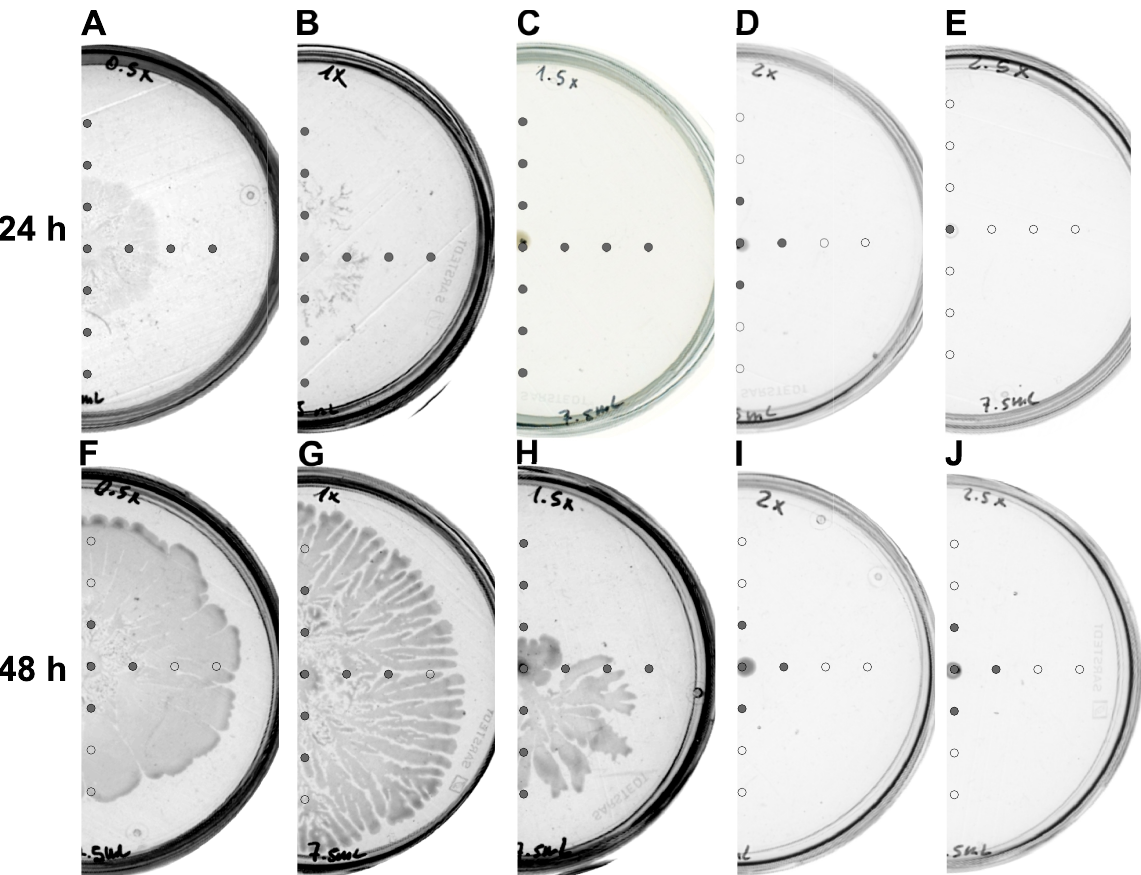
Fig 2. Swarming and AHLs production by Dickeya solani IFB102 on plates containing 0.5% of agar and the changing concentrations of B- medium: (A, F) 0.5x, (B, G) 1x, (C, H) 1.5x, (D, I) 2x, (E, J) 2.5x. Swarming assays were performed for 24 and 48 h, as indicated. Grey circles represent spots at which AHLs were detected. Open circles represent spots at which no AHLs were